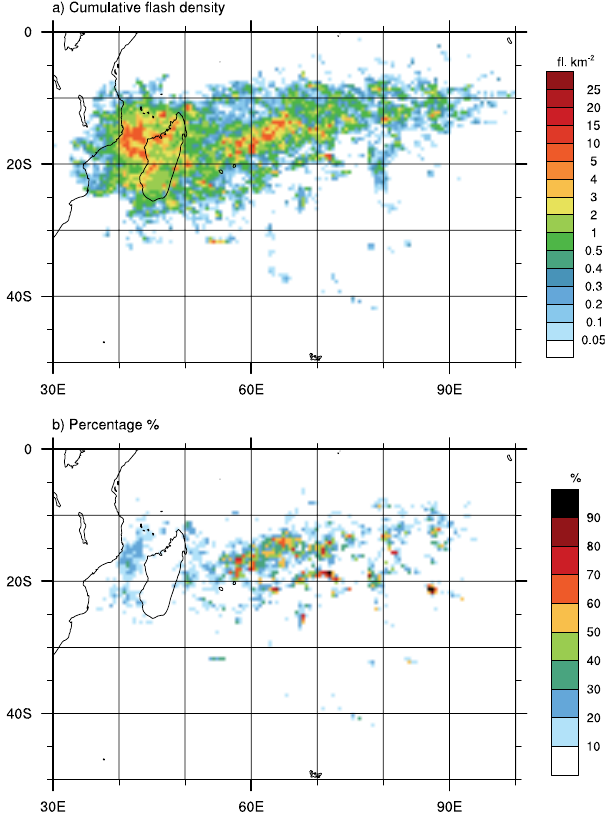
Fig. 3. Impact of tropical storms on the global lightning activity in the SWIO between cyclonic seasons 2005/2006 and